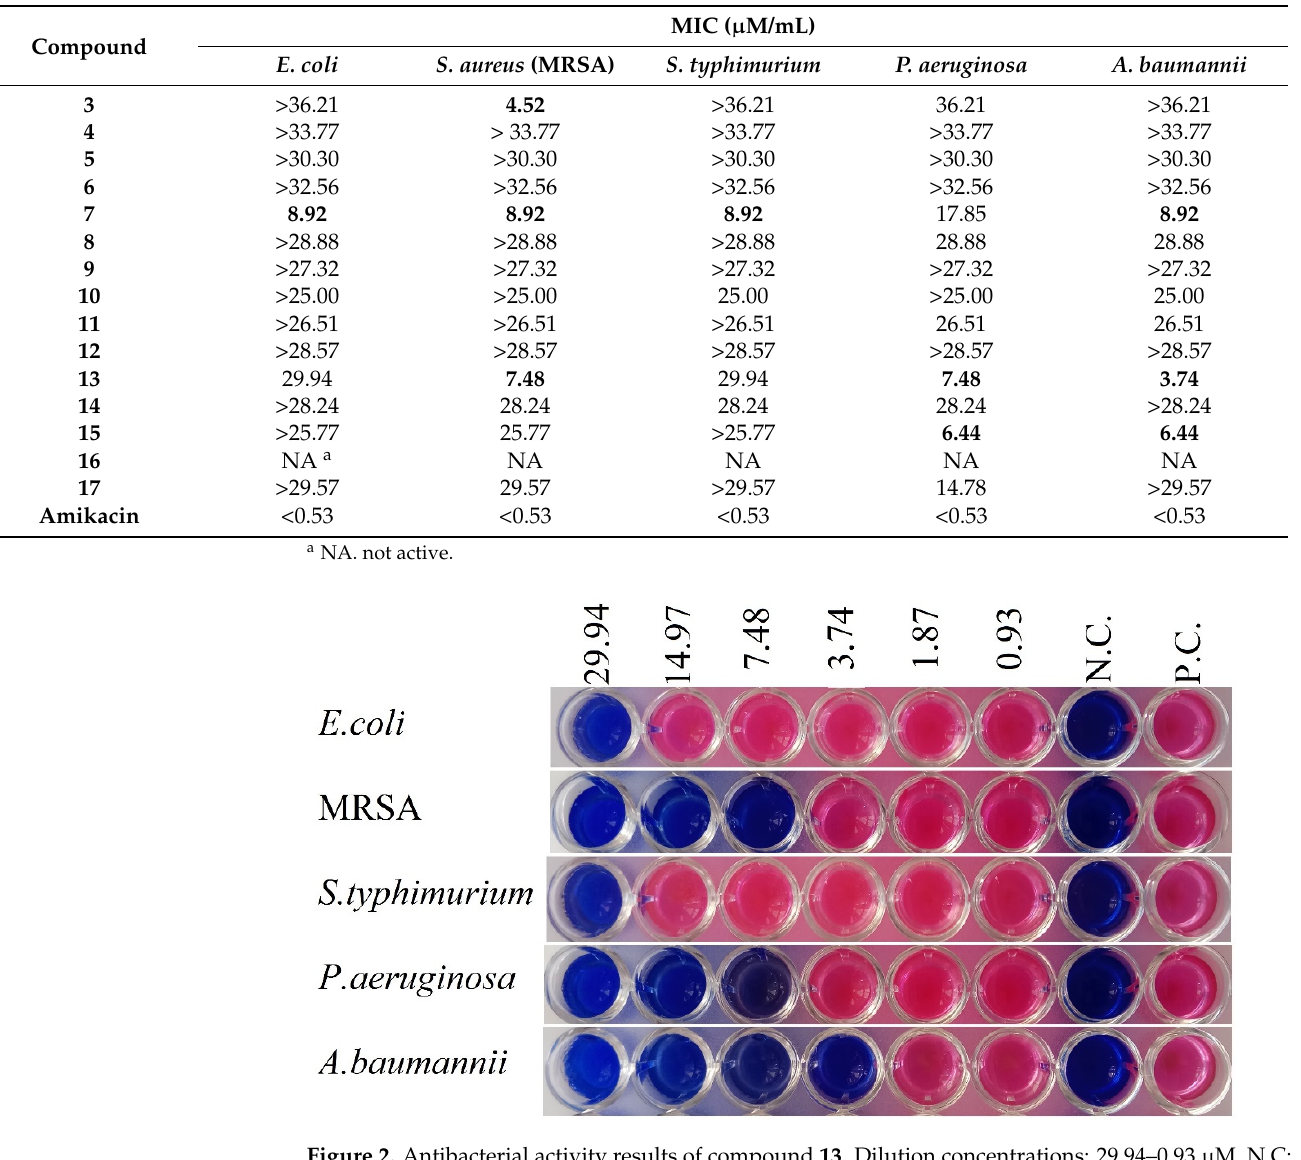
Figure 2. Antibacterial activity results of compound 13. Dilution concentrations: 29.94–0.93 µM. N.C: negative control. P.C: positive control.